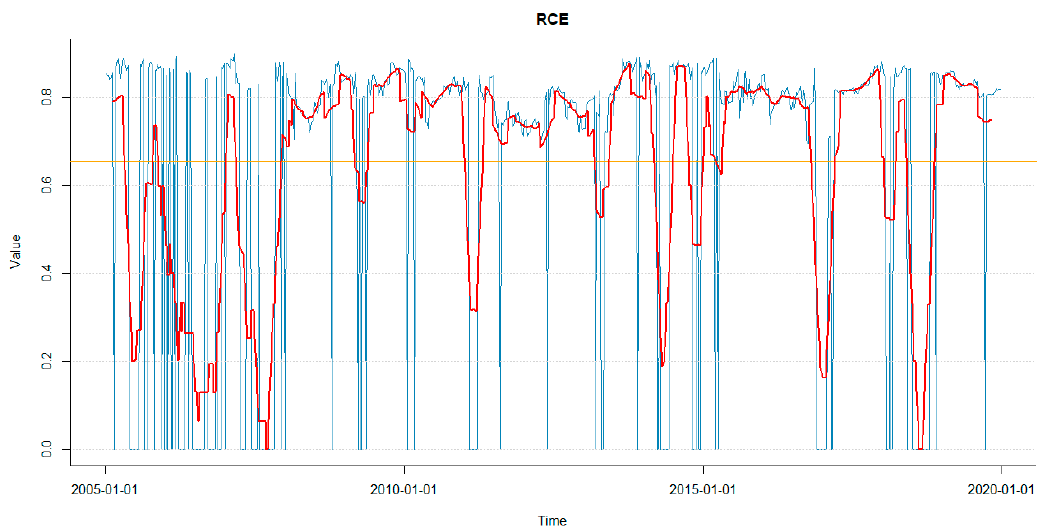
Figure 10. Rich club effect (RCE) during the period from 7 January 2005 to 20 December 2019. Red lines depict the 13 periods of the moving average smoothed series. Source: Own study.